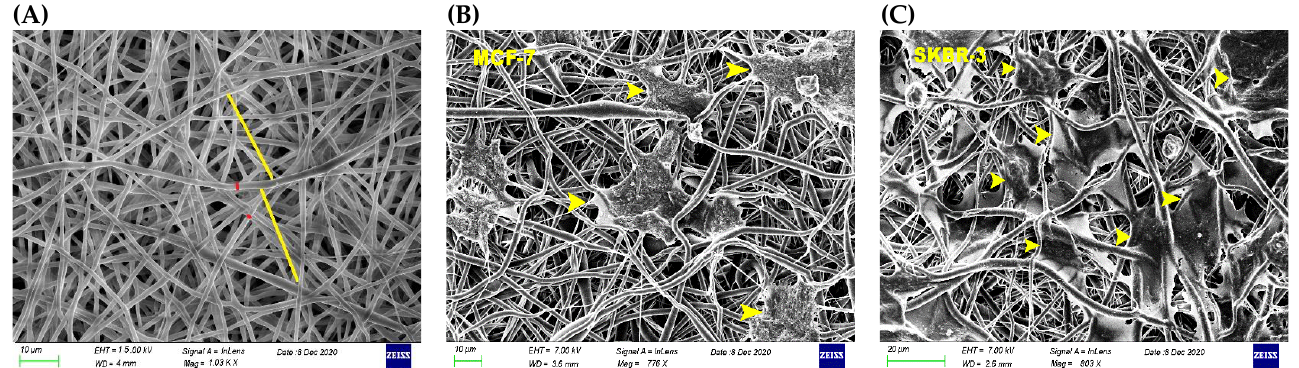
Figure 2. SEM micrograph of 3D PCL scaffolds, yellow and red lines indicate the created pore size and the fiber diameter of PCL scaffolds, respectively ( A ). Cells were seeded on 3D PCL collagen immersed scaffolds and tested for cell viability and morphology during a dynamic condition in the control and post treatment phases. Yellow arrows indicate the way of MCF-7 ( B ) and SKBR-3 ( C ) cells were seeded into 3D scaffolds. Moreover, cancer cells exhibited immunofluorescence assay to estimate the post-treated F-actin morphology.